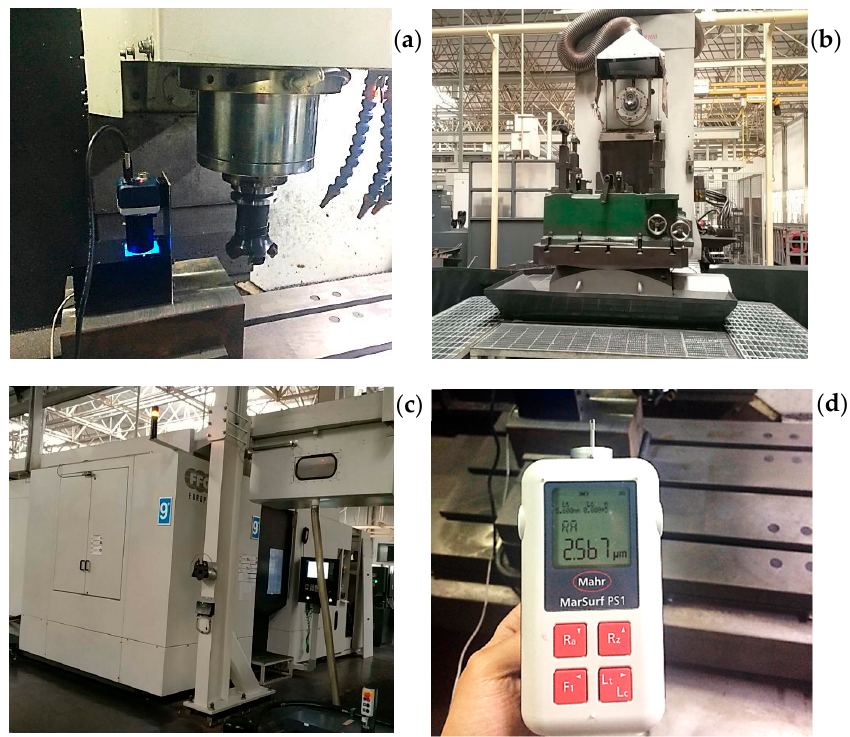
Table 1. Information of the milling cutting experiment.